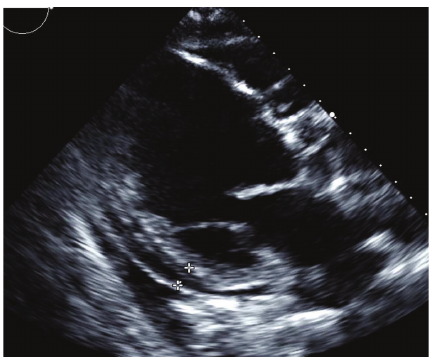
Figure 2: Transthoracic echocardiogram showing a moderate-sized pericardial e ff usion